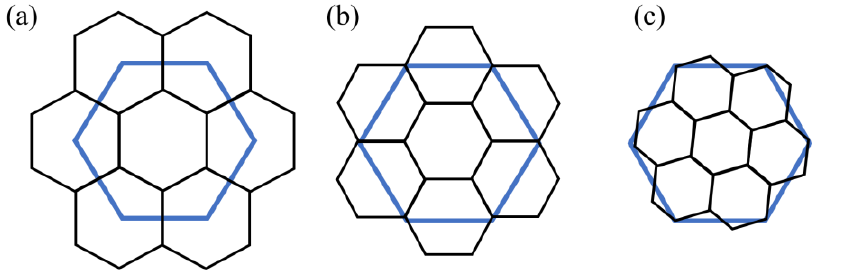
Figure 2. Hexagonal grids with different apertures: (a) Aperture 3; (b) Aperture 4; and (c) Aper- ture